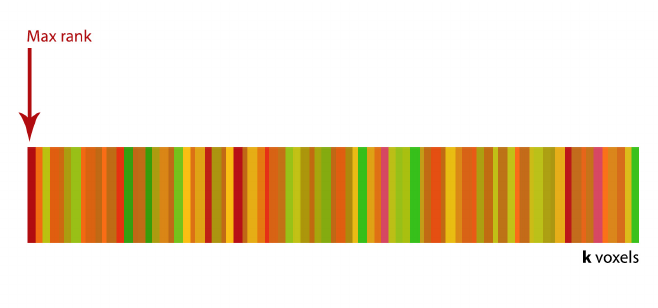
Figure 4. Example of a saliency table with size k , comprising most salient